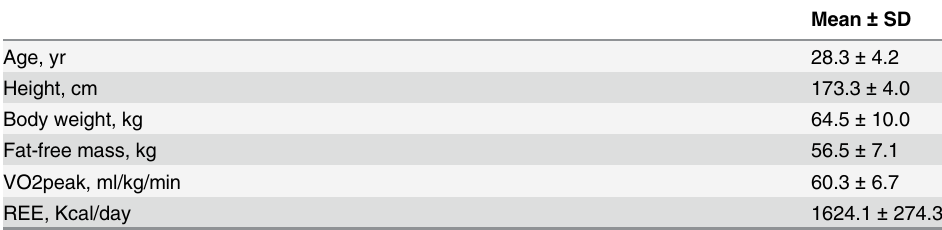
Table 3. Characteristics of participants.